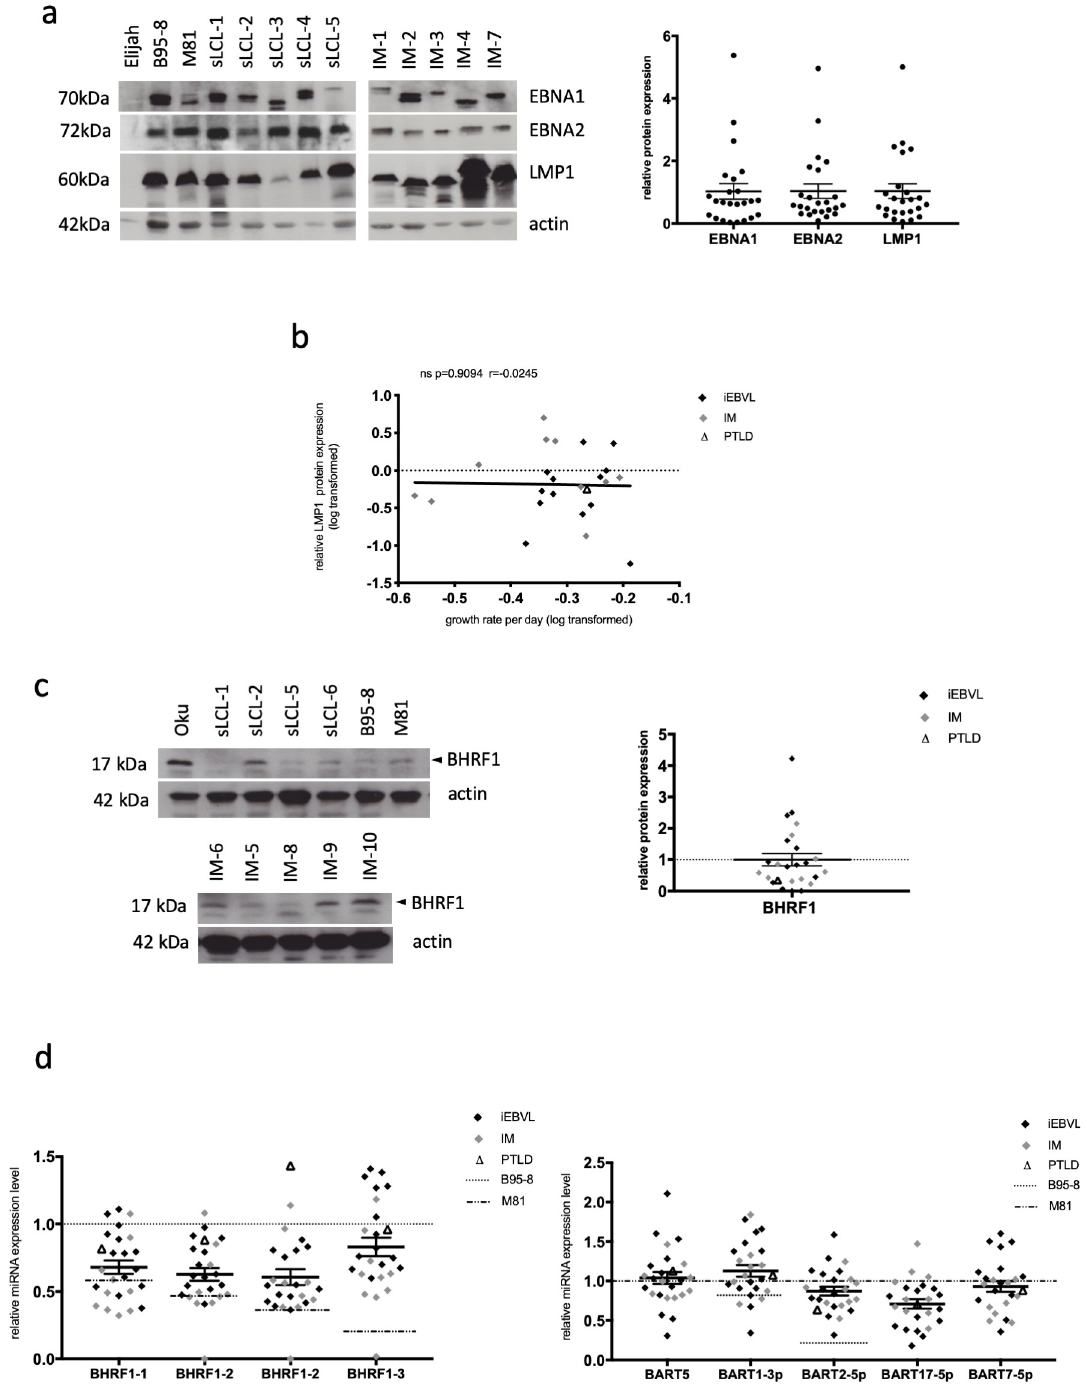
Fig 3. Latent protein and viral miRNA expression in spontaneous LCLs from patients with IM and iEBVL. (a) The figure shows the results of a western blot analysis that was performed on the panel of sLCLs with antibodies specific for EBNA1, EBNA2 and LMP1. Antibodies specific to actin were used as a loading control. Elijah served as an EBV-negative control. We quantified the protein signals using the ImageJ software. Signals were first given normalized to actin and then to the mean of the obtained values. Mean and standard error of protein expression levels are given in a dot plot. We show as an example the expression pattern in a subset of sLCLs from 10 IM (IM-1 to IM-4 and IM-7) and transplant recipients (sLCL-1 to sLCL-5), as well as in B-cells from a single individual infected with B95-8 or M81. (b) The graph shows the correlation coefficient between the growth rate of the investigated sLCLs and LMP1 protein expression levels. The values of the growth rates have been log-transformed to obtain a normal distribution. (c) Western blot analyses